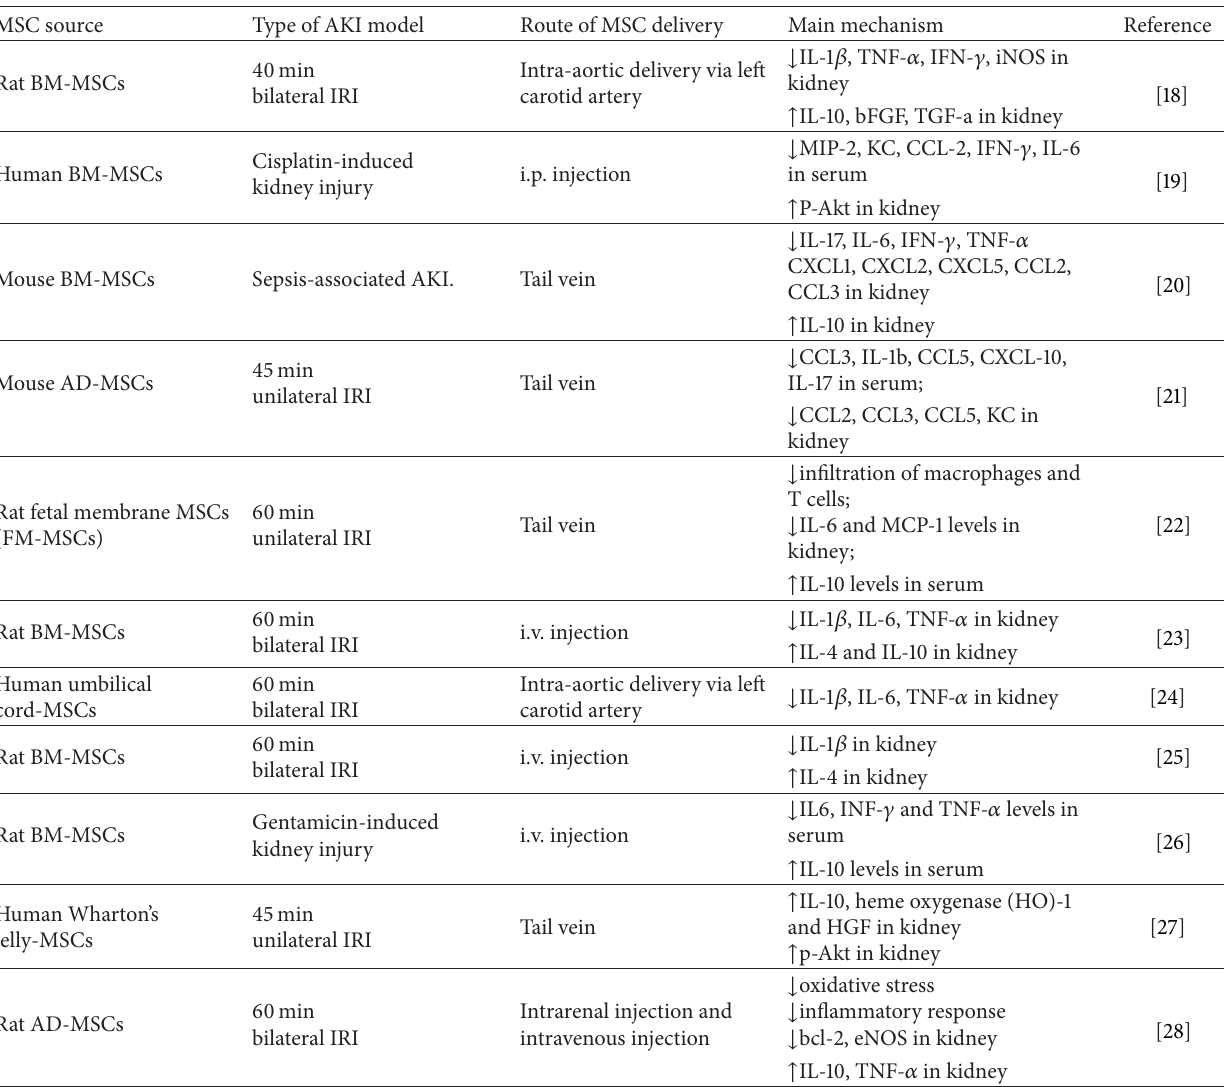
Table 1: Preclinical studies using mesenchymal stem cells isolated from various sources to treat acute kidney injury. All the results showed that MSCs could ameliorate the kidney injury [18–28] (main mechanism involving inflammatory mediators).